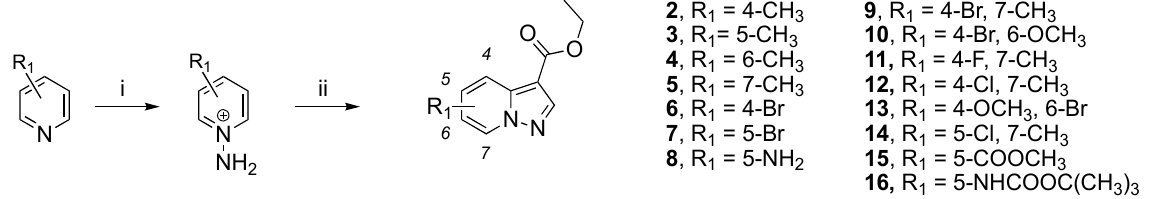
Figure 2. The compound B-1 and the structural features of the three series synthesized in this study; Series 1 with changes around the core depicted in blue, Series 2 with changes to the ester depicted in orange and Series 3 with various alkyne extensions depicted in